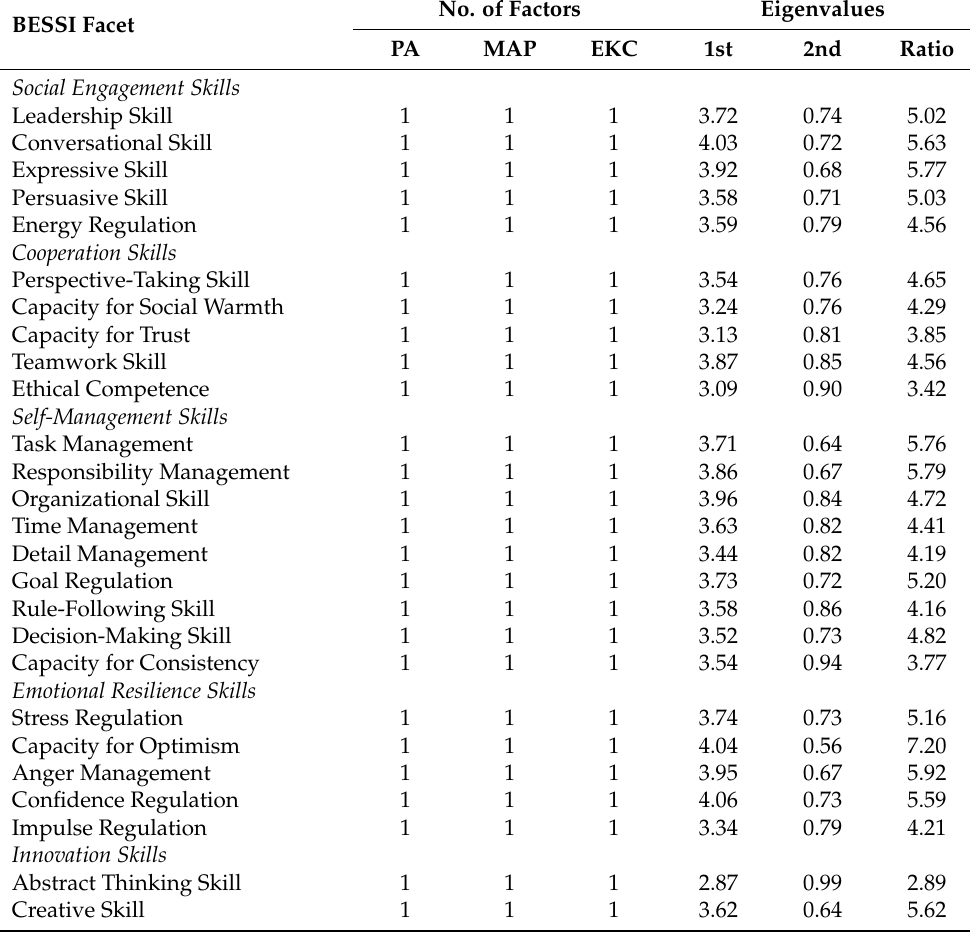
Table A1. Dimensionality of the 32 facets of BESSI-G v0.1 (Study